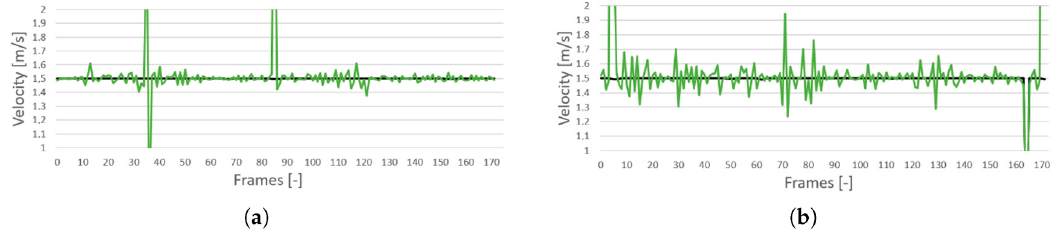
Figure 12. Calculated velocity of robots: ( a ) white robot; ( b ) black